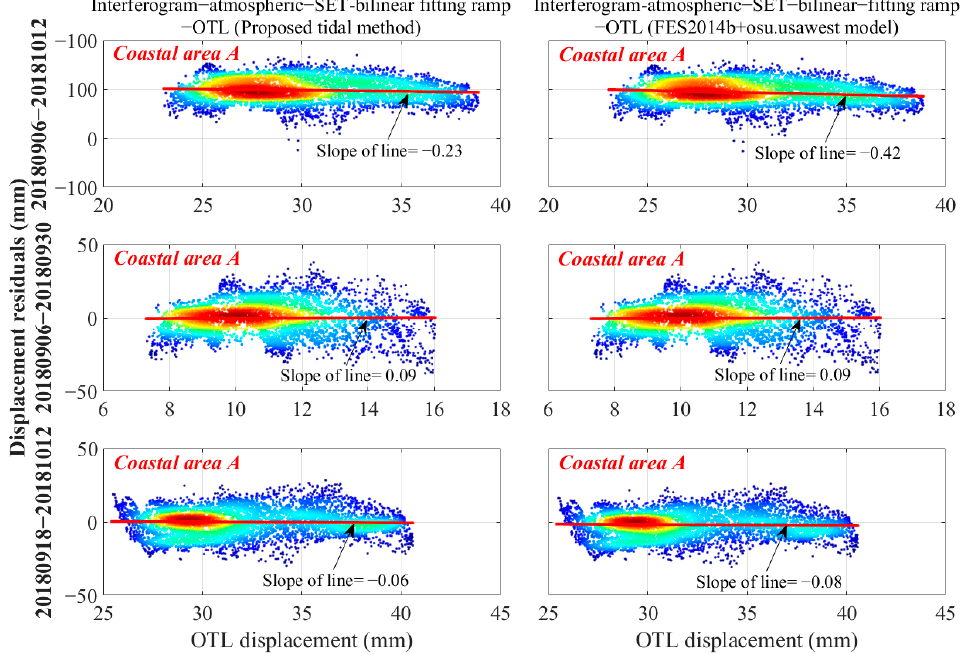
Figure 10. The comparison of the displacement residuals in a complex coastline area of the long-strip differential interferograms after the tidal displacements was corrected using the proposed tidal method and FES2014b+osu.usawest model.